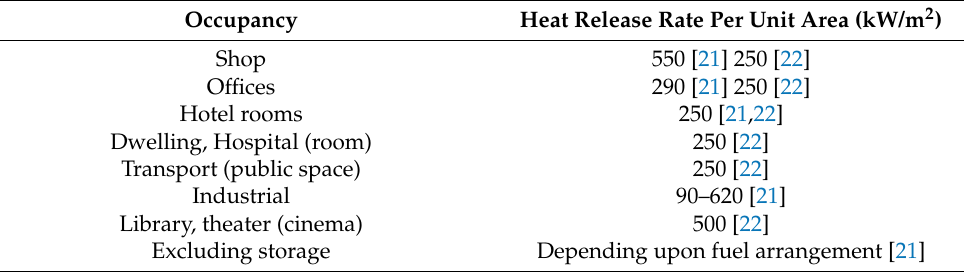
Table 1. HRRPUA for different occupancies [23,24].